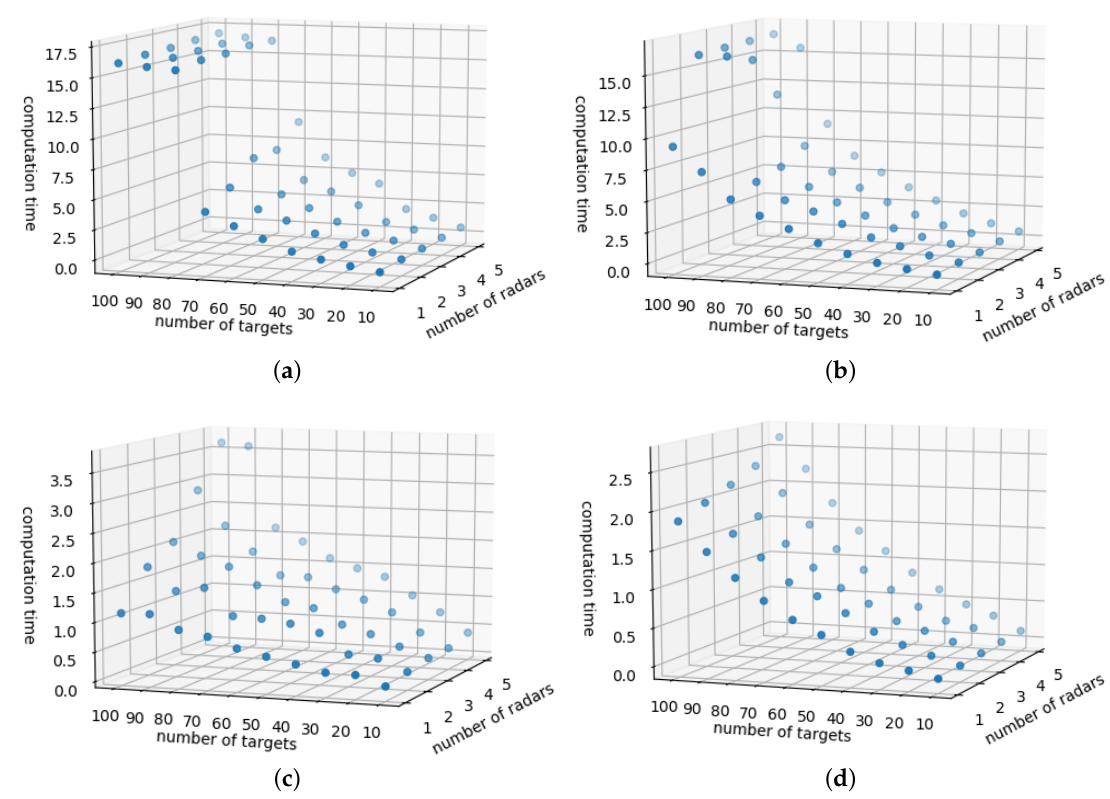
Figure 13. MILP formulation complexity as of computation time according to the change of simultaneous tracking capability. ( a ) Computation time when n capa = 10. ( b ) Computation time when n capa = 15. ( c ) Computation time when n capa = 20. ( d ) Computation time when n capa =